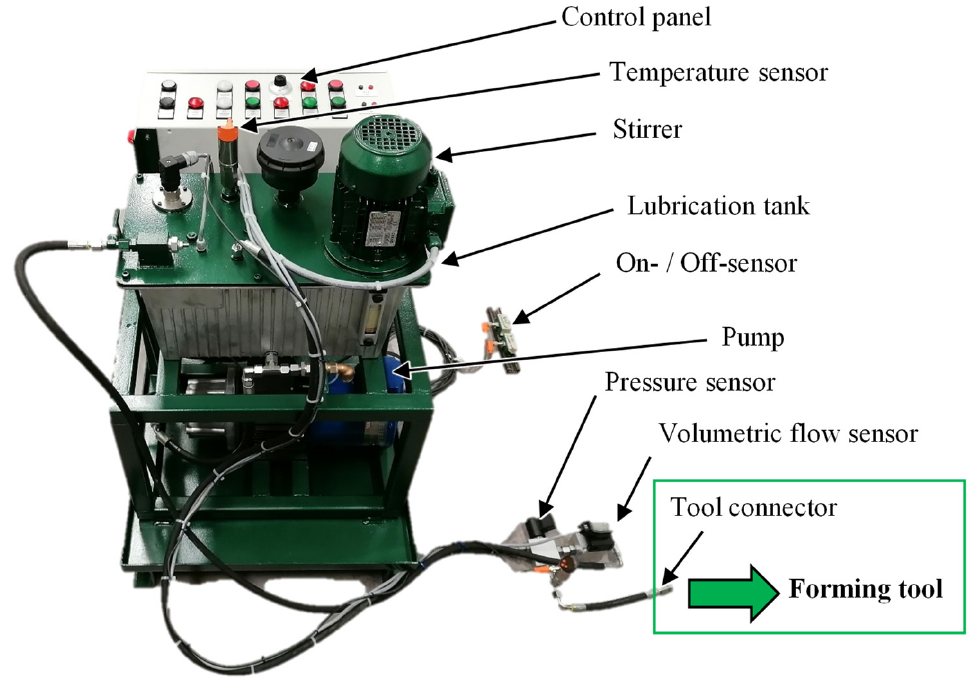
Figure 8. Hydraulic metering device for process-integrated lubrication experiments.